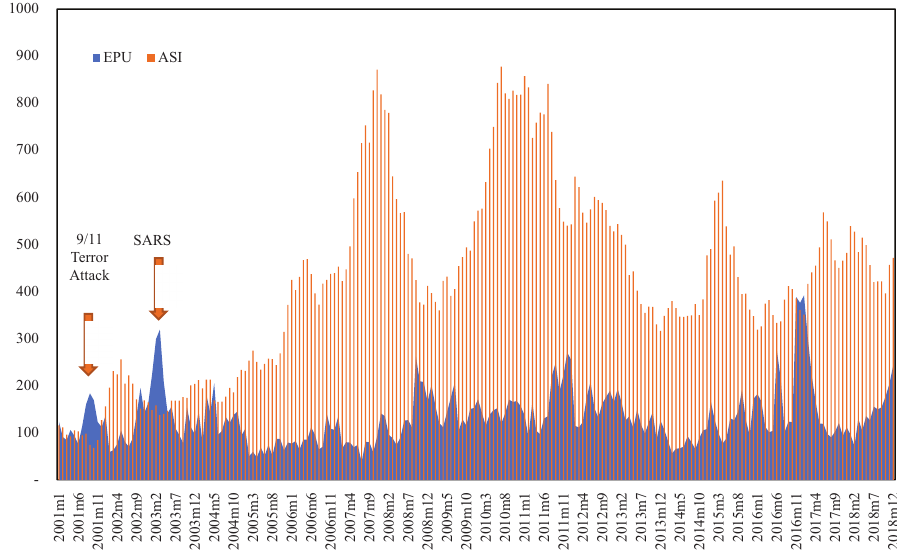
Figure 2. Trends of EPU and the ASI in Korea (2001–2018)